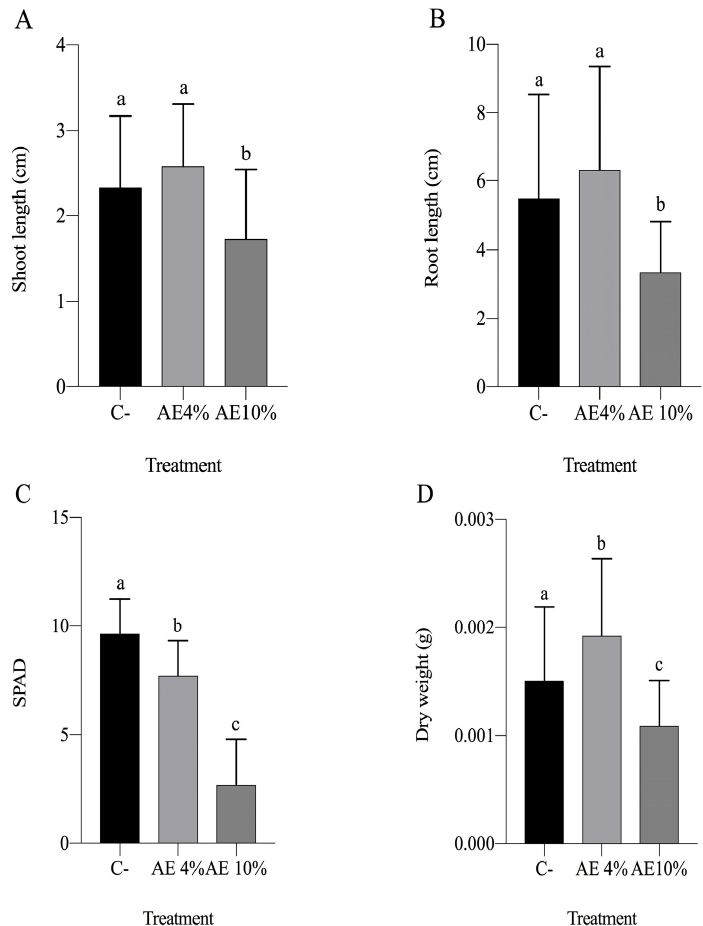
Figure 6. Substrate leaching bioassay with lettuce. Parameters (12 days of application of treatments): ( A ) shoot length, ( B ) root length, ( C ) chlorophyll content, and ( D ) seedling dry weight. Abbreviations: C- (distilled water), AE 4% (aqueous extract at 4%), AE 10% (aqueous extract at 10%). Bars represent the mean + SD. Different letters indicate a significant difference by one-way ANOVA and Tukey test ( p ≤ 0.05).